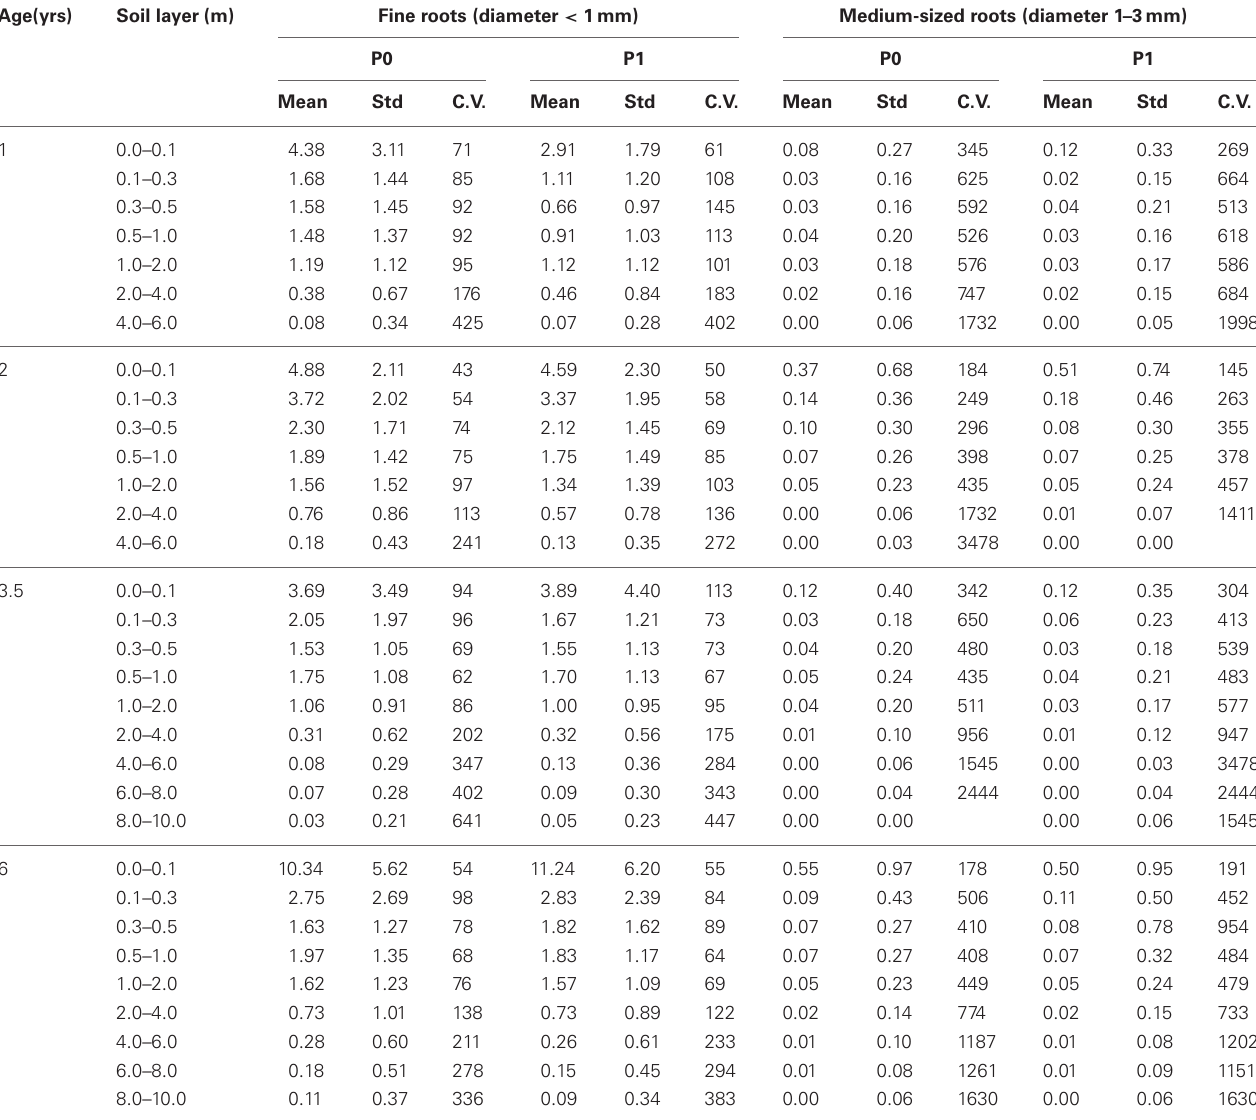
Table 3 | Mean, standard deviation (Std), and coefficient of variation (CV expressed in %) of fine and medium-sized root intersects counted in 25cm 2 grid cells (number of roots per 25cm 2 ) on the P0 (close to the stump) and the P1 (at mid distance between two trees in the planting row) soil